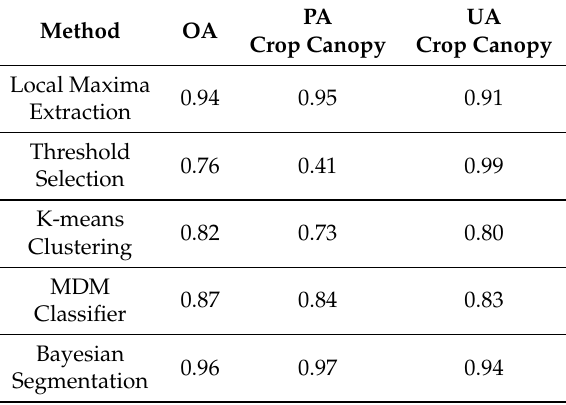
Table 6. Vineyard site: assessment of the best results of each detection method.